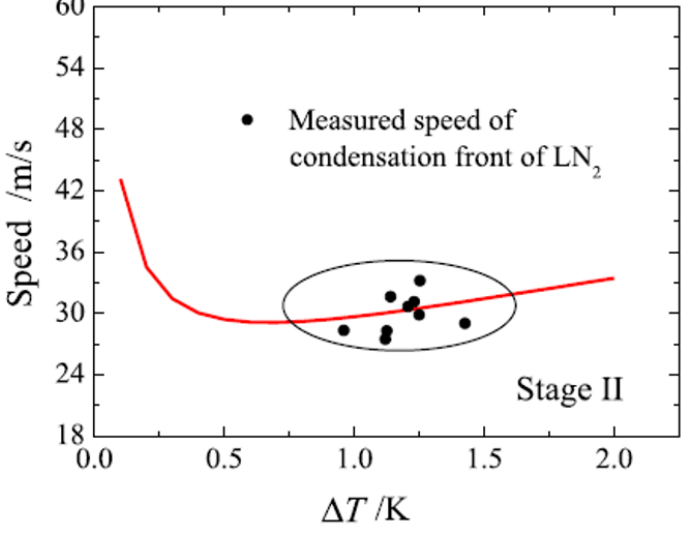
Figure 9. Measurements of the speed of sound with the temperature depression and comparison with the theoretical formulation from Wallis (in red) [103]. Reprinted from [103], Copyright (2017), with permission from